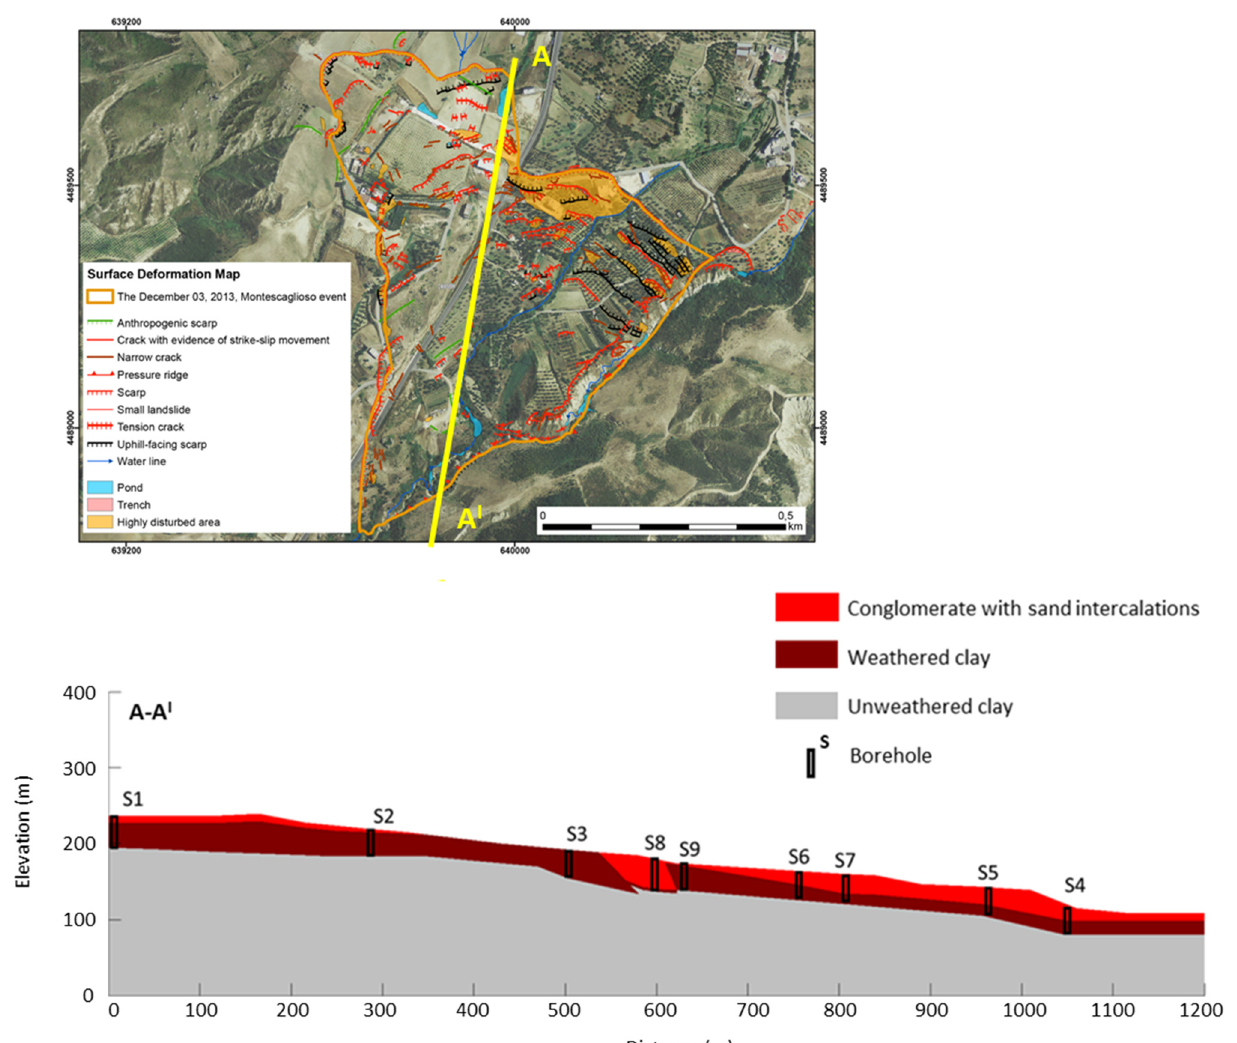
Figure 4. Geological longitudinal cross-section of the landslide area. In the sketch, the geomorpho- logical map (modified from [11]) and the section trace are shown.